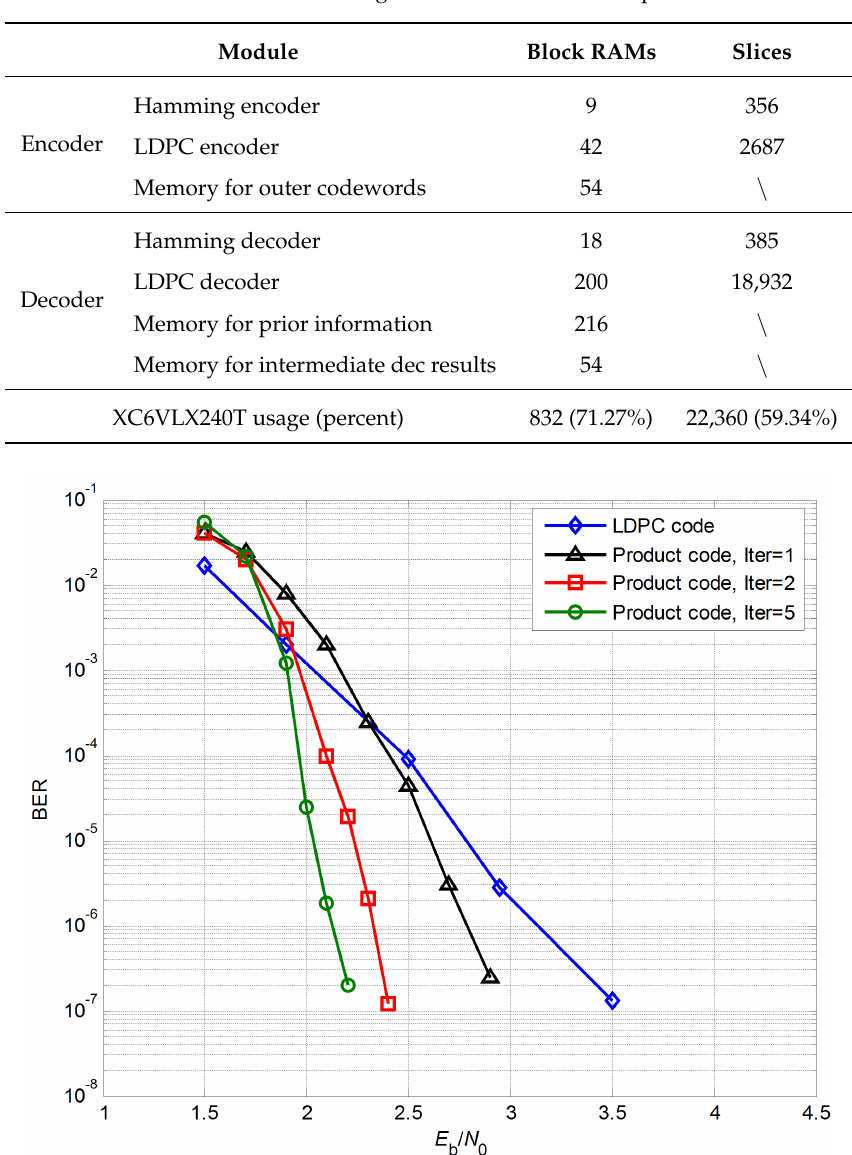
Figure 12. FPGA evaluation results of product codes with LDPC (576, 288) and Hamming (127,